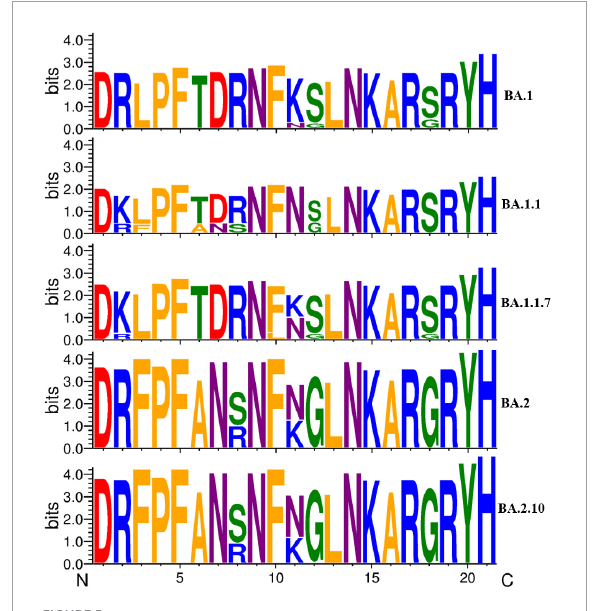
A sequence logo representation of the RBD region of major Omicron variant spike protein in which letter height reflects the likelihood of finding a particular residue in that position. Residues are colored according to hydrophobicity (orange—hydrophobic, blue—basic, red—acidic, purple—neutral, green—polar).